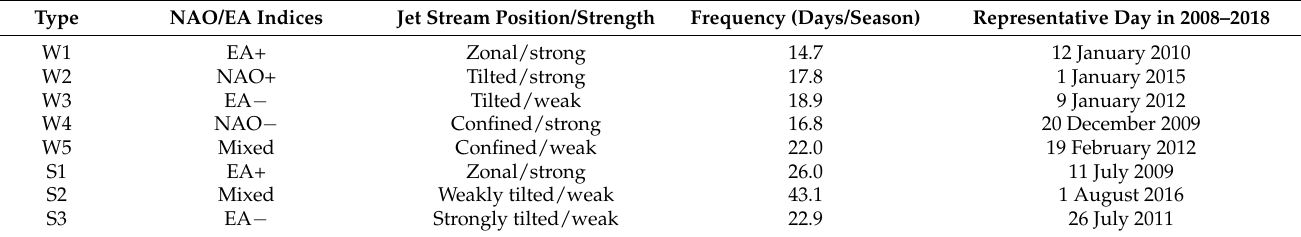
Table 3. North Atlantic weather types for winter and summer. This classification refers to Table 1 of Irvine et al. [34]. In the second column, “+” stands for positive regimes of the North Atlantic Oscillation (NAO)/East Atlantic (EA) patterns, where anomaly fields have the same structure as typical NAO and EA teleconnection patterns; and “ − ” stands for their negative regimes, where anomaly fields have the same structure of the opposite